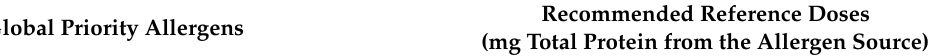
Table 1. Summary of the FAO–WHO expert panel recommended priority allergen and their reference doses for risk management through food